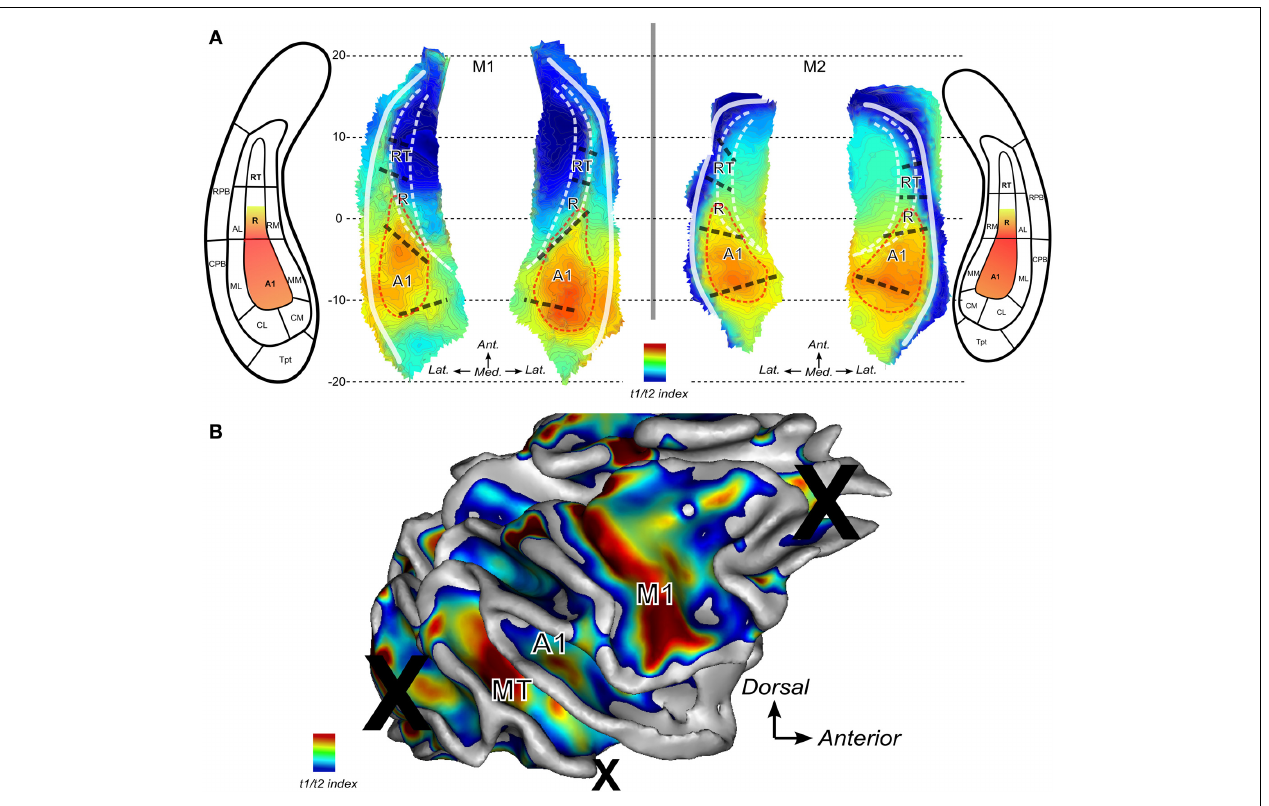
FIGURE 6 | Anatomical index derived from ratio between T1 and T2 weighted MR images. The ratio of T1 over T2 weighted MR images is used to derive a gradient of change across cortical thickness. Maps show higher indices where higher intensities are found in gray matter. (A) Maps the lateral